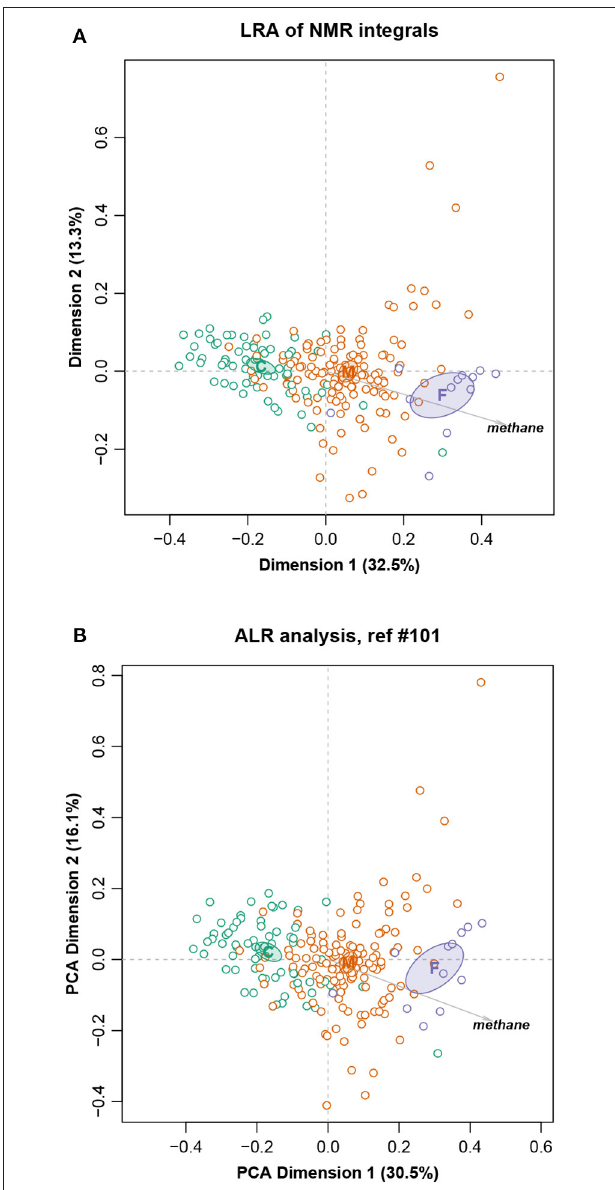
FIGURE 8 | (A) Logratio analysis of the Cows data; (B) Principal component analysis of the additive logratios with reference integral number 101. Ninety-five percent confidence ellipses are shown for the three group means that are situated at the diet labels C (concentrate), M (mixed) and F (forage), as well as the supplementary variable methane. The geometry of the ALRs has a Procrustes correlation of 0.9902 with the exact geometry of all pairwise